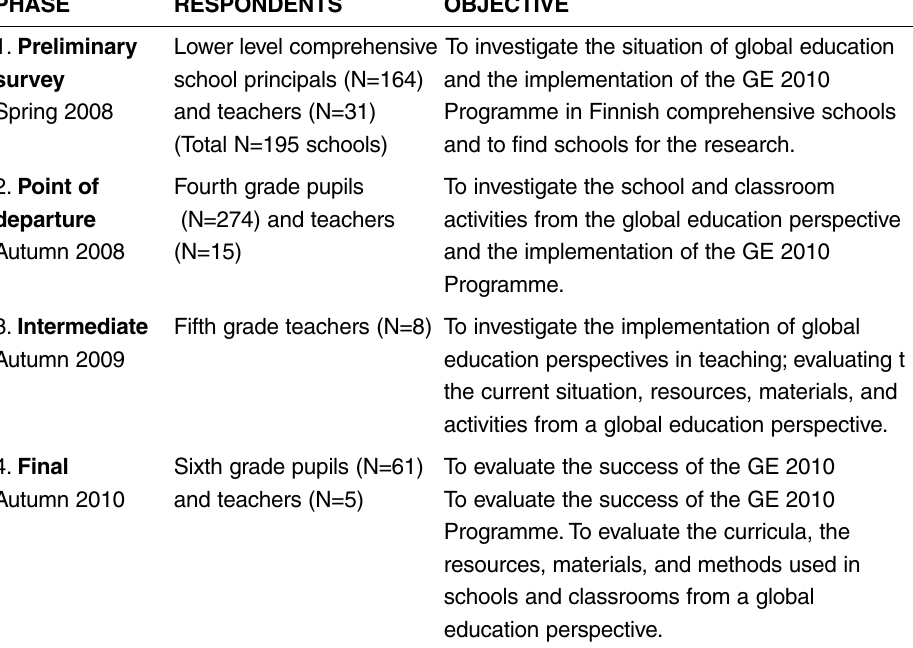
Table 1.The phases, respondents, and objectives of the research on global education in Finnish comprehensive schools lower